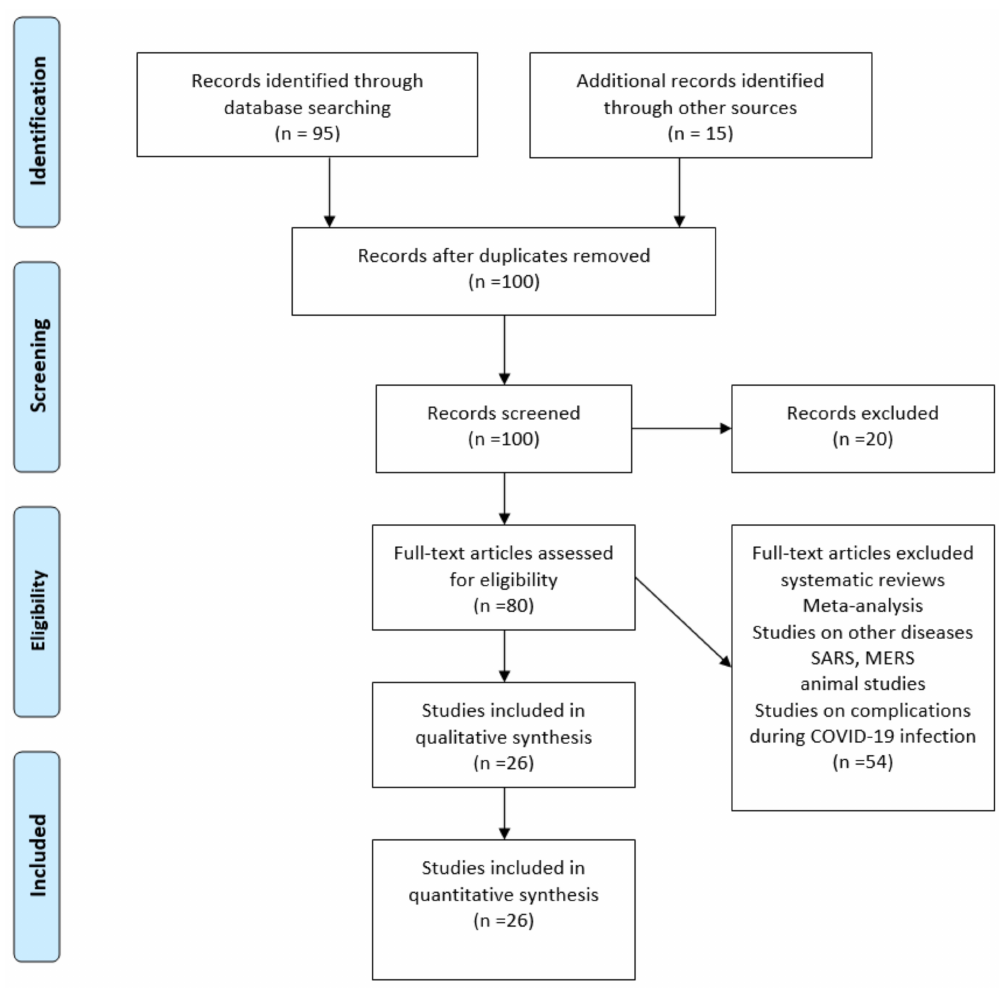
Figure 1. PRISMA flow